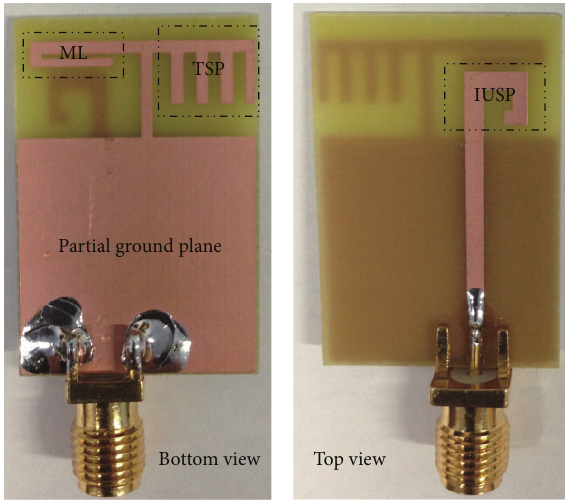
Figure 5: Fabricated antenna.